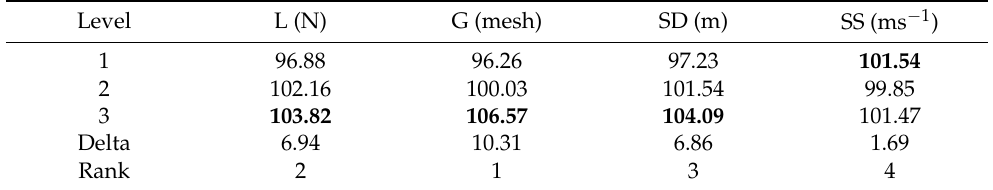
Table 7. Response table for SNRs of T s (smaller is better).